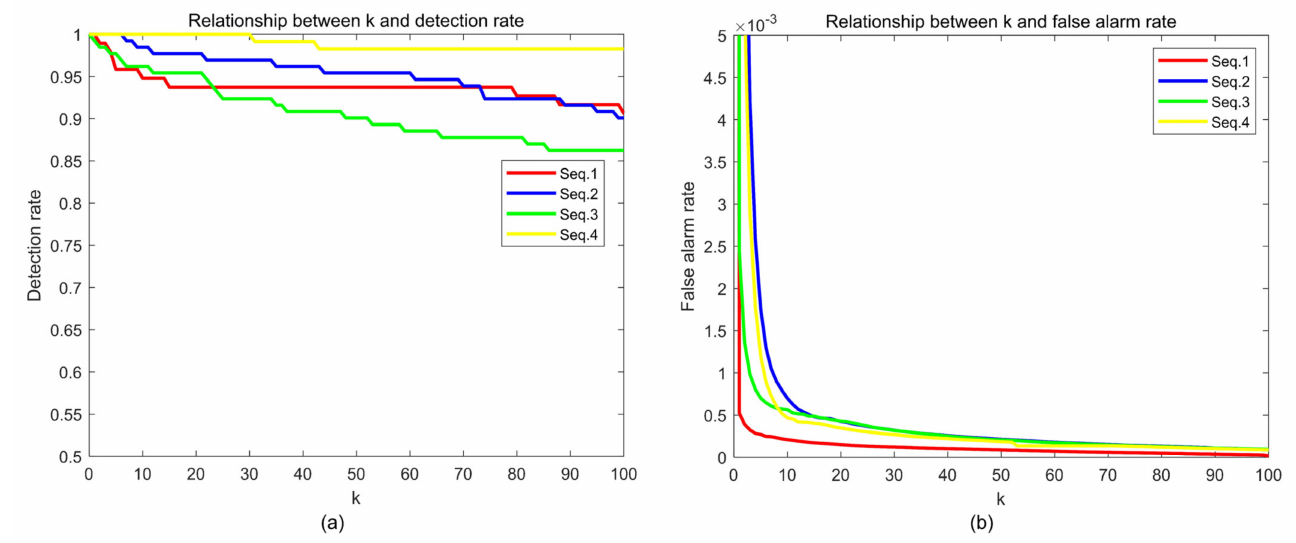
Figure 12. Influence of k . ( a ) Relationship between k and P d ; ( b ) relationship between k and P f